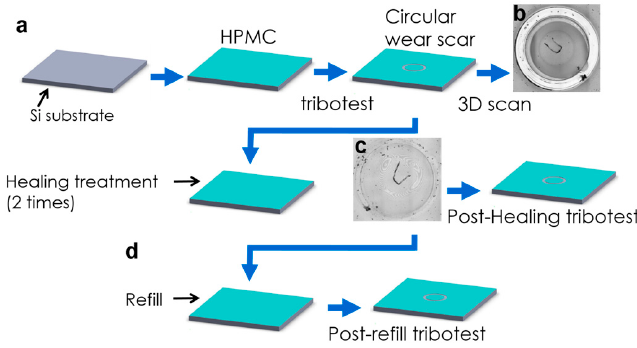
Figure 1. ( a ) Schematic illustration of experimental steps; 3D scanning image of hydroxypropyl methylcellulose (HPMC) surface ( b ) with circular wear scar after the tribotest; ( c ) after healing treatment; ( d ) refill process and post-refill tribotest.